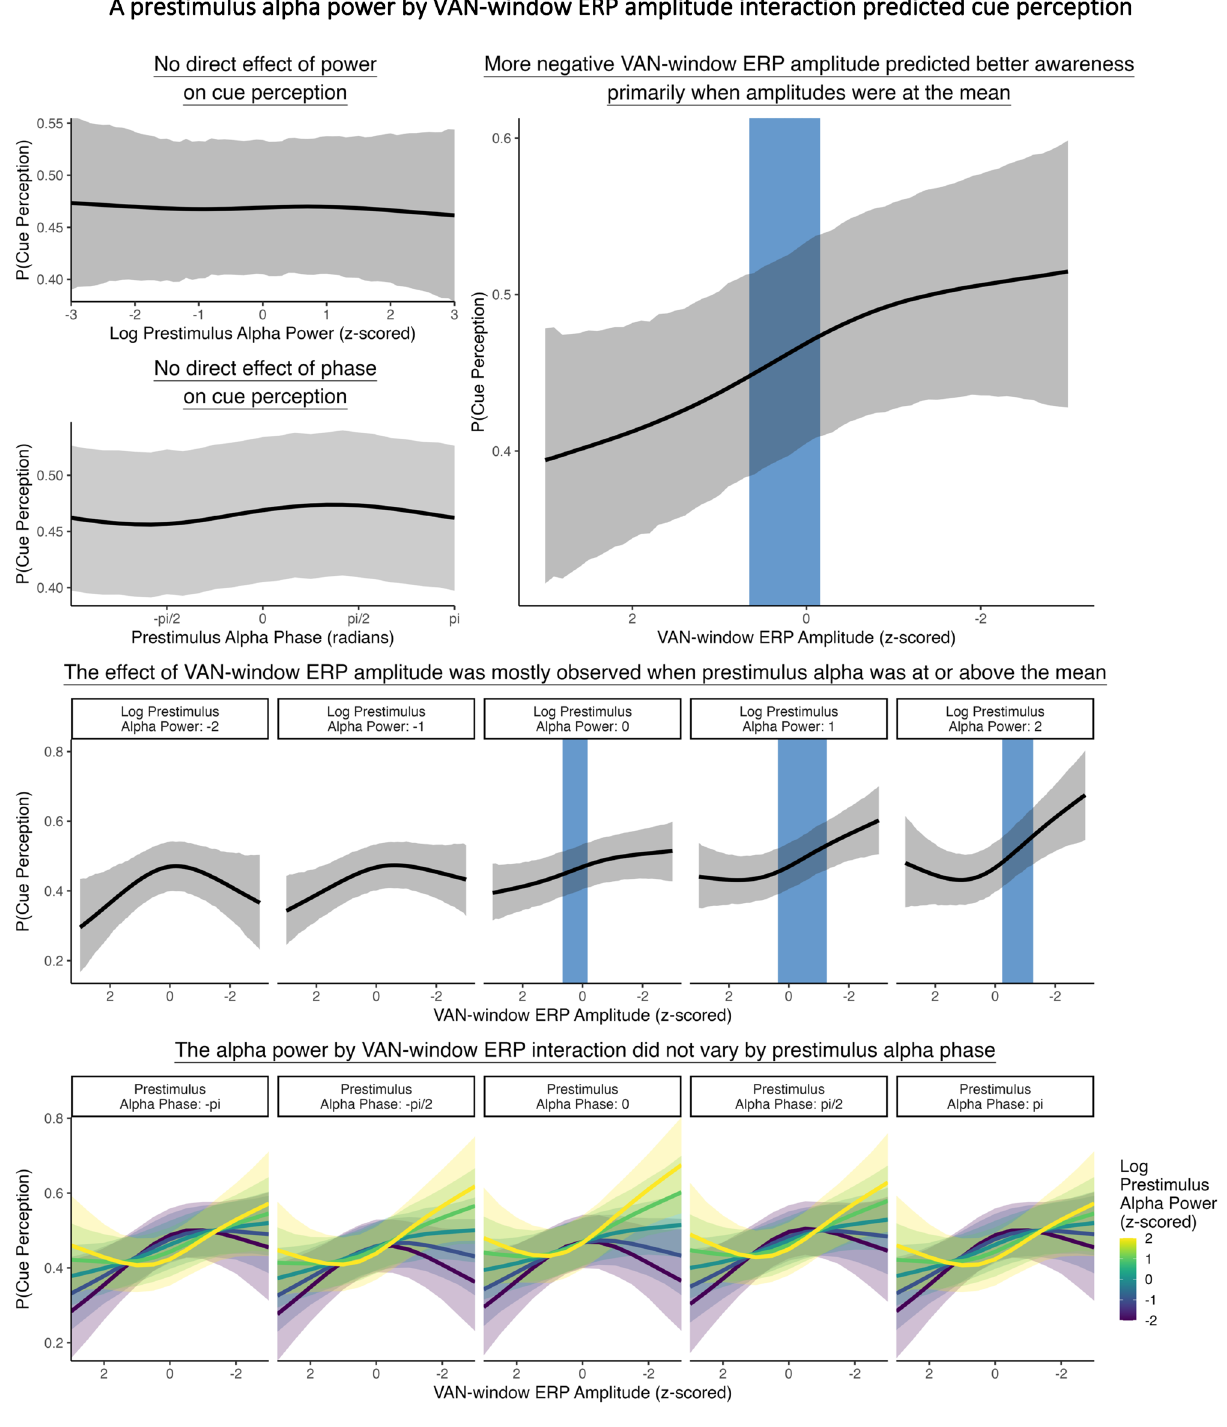
Figure 5. The effects of prestimulus alpha (power and phase) and VAN-window ERP amplitudes on cue perception. A more negative VAN-window ERP amplitude was associated with better cue perception (upper right panel). This effect was mostly observed when prestimulus alpha power was elevated, but there was only anecdotal evidence of this interaction (middle panel). There also was no three-way interaction (bottom panel). Blue shaded regions represent where slopes were BF > 10 for the simple effects and the prestimulus alpha power by VAN-window ERP amplitude